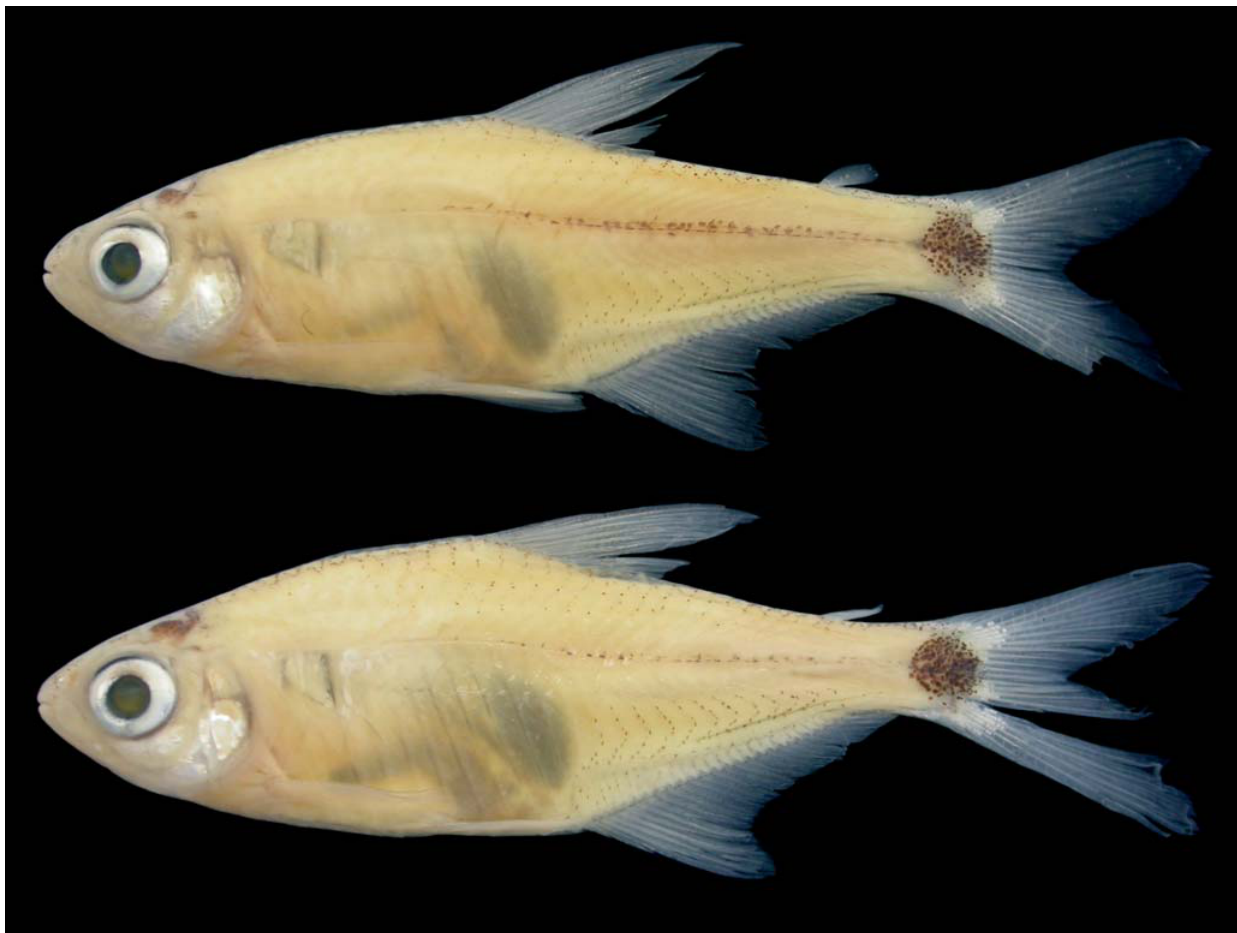
Fig. 19. Holotype of Odontostilbe nareuda , CBF 09621, male 33.1 mm (top), and paratype FMNH 106433, possibly a female 32.3 mm SL, not showing dimorphic characters of males (bottom).